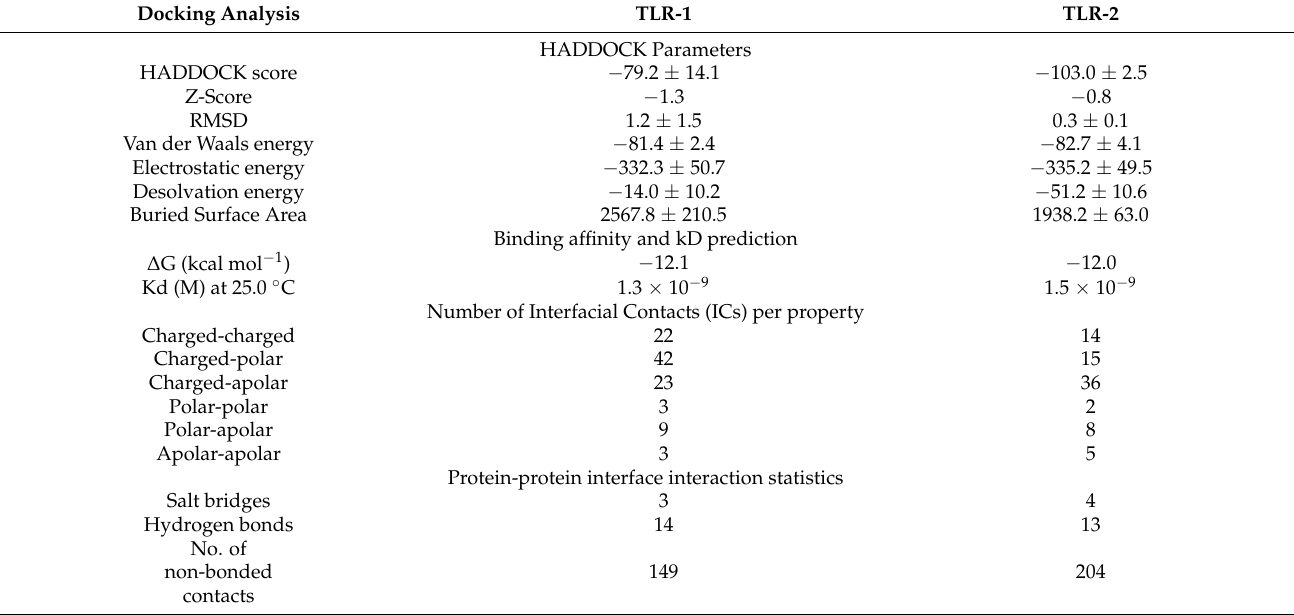
Figure 7. A schematic depicting the docked complex of TLR-2 with vaccine and their residue interactions ( A ) The TLR-2 is illustrated in forest green color, and the vaccine (in hot pink) is displayed bonded to it ( B ) Interface residue interaction. There are 13 hydrogen bonds between the docked complex depicted in blue lines. Residues are shown in multiple colors to show their properties e.g., positive (blue); negative (red); neutral (orange); aliphatic (gray); aromatic (purple). Table 5. Docking analysis of TLR-1 and TLR-2 to the vaccine